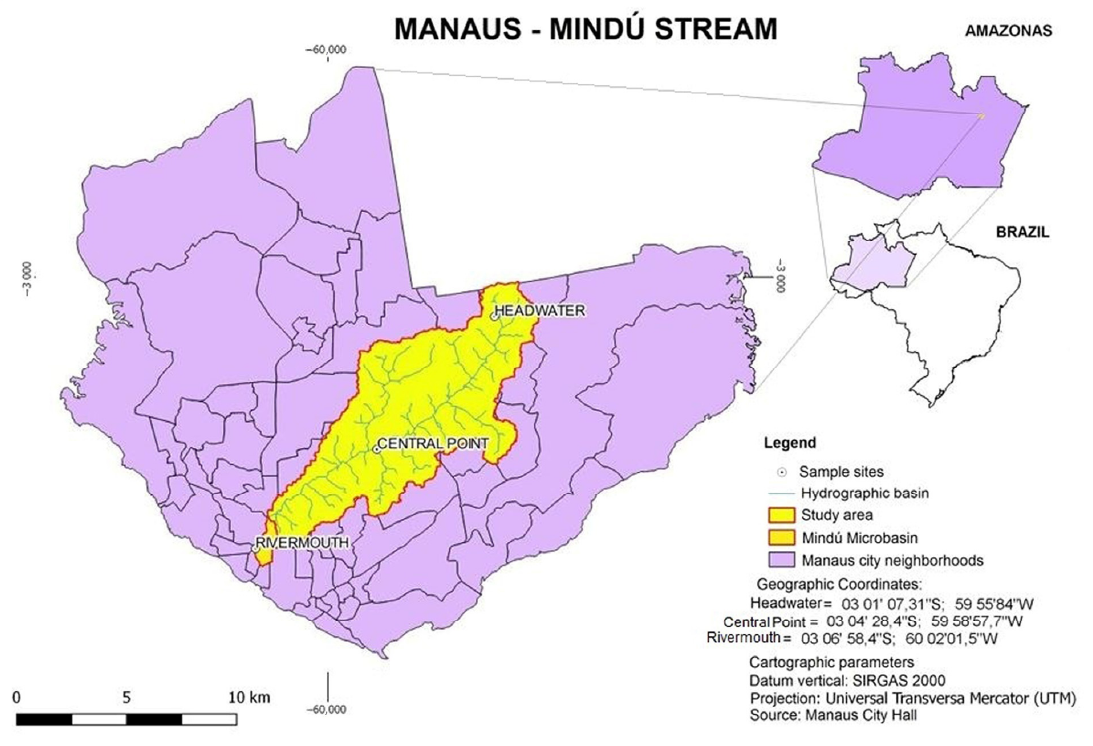
Figure A1. Map of Manaus city (Amazonas, Brazil) showing the research site and sampling points distributed at Mindú stream.